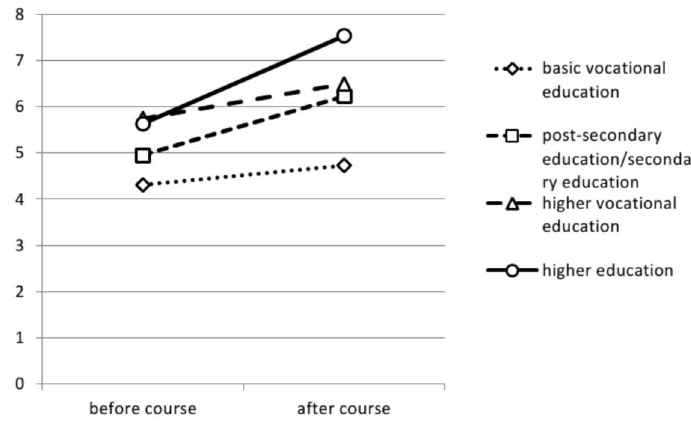
Figure 3a. The level of participant knowledge of principles of nutrition before and after the course, taking level of education into account